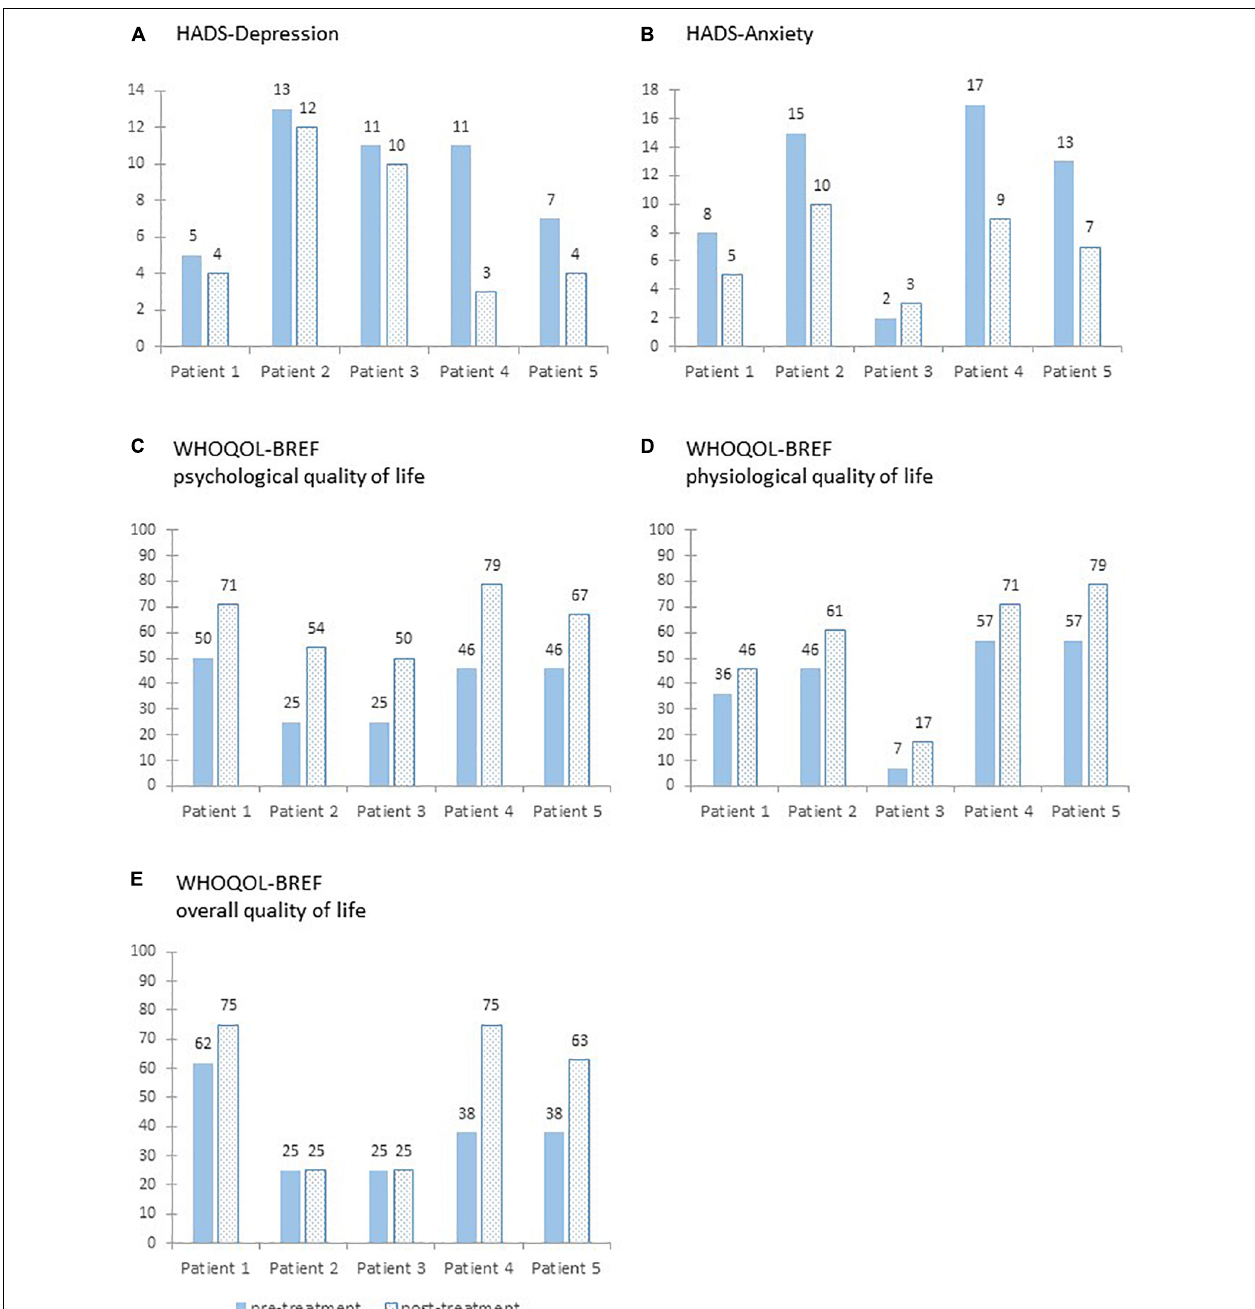
FIGURE 3 | Sum scores on the two subscales of the Hospital Anxiety and Depression Scale (A,B) and transformed sum scores on the World Health Organization Quality of Life Assessment (C–E) pre- and post-treatment for each